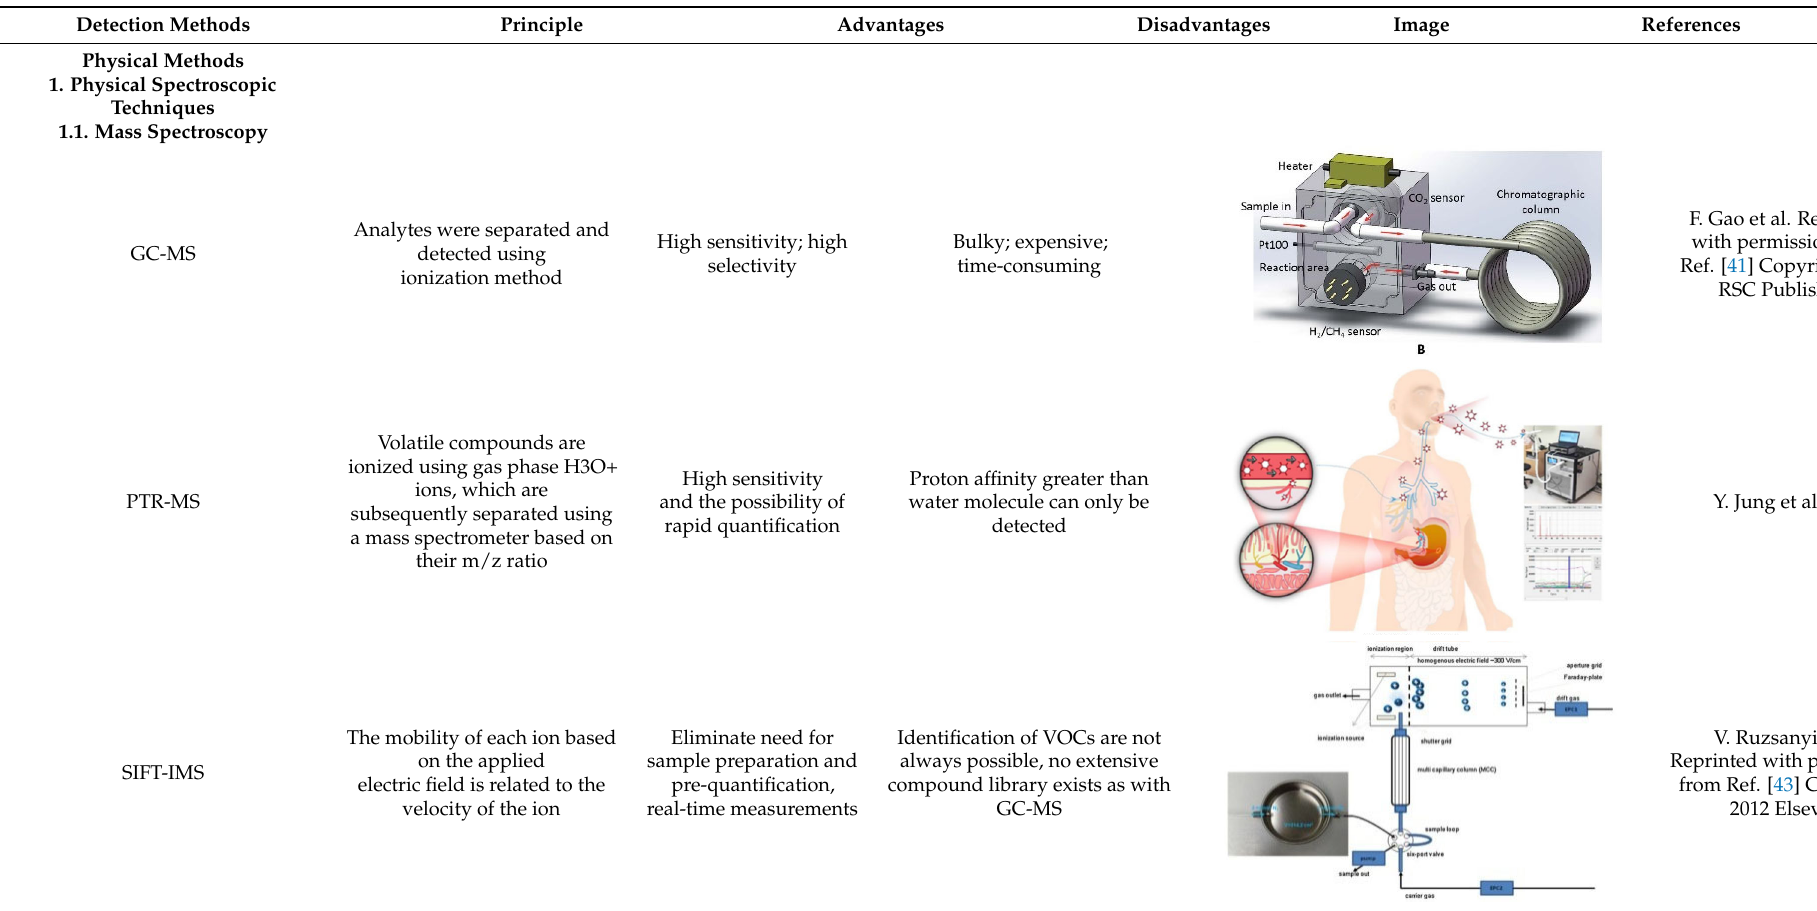
Table 2. Various detection techniques for exhaled breath VOCs.